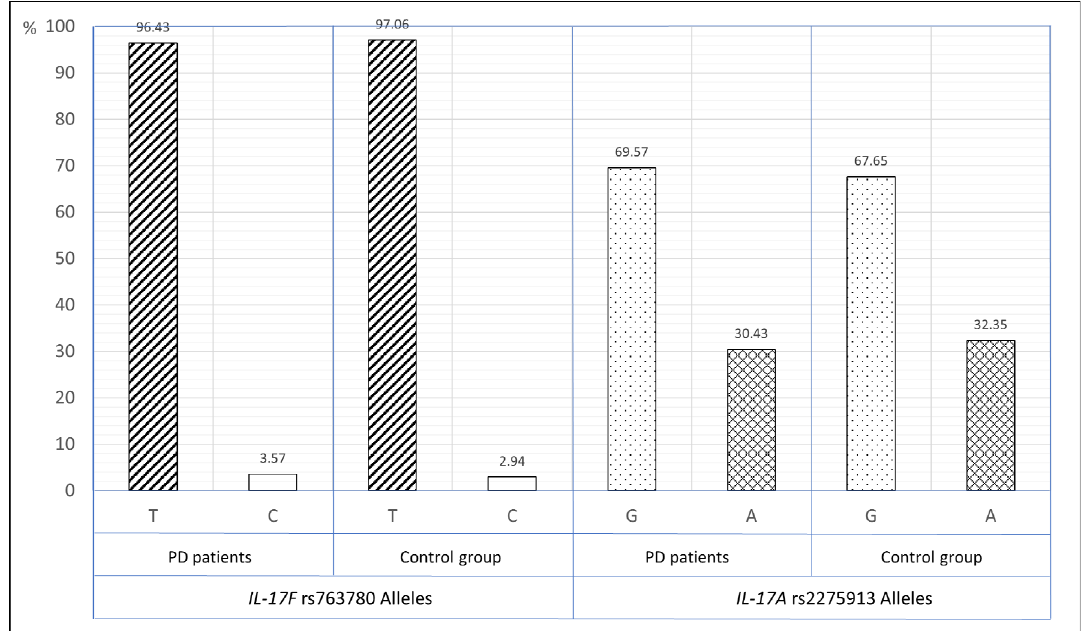
Figure 3. The distribution of IL-17F rs763780 and IL-17A rs2275913 alleles in periodontitis patients and control group in smokers group.